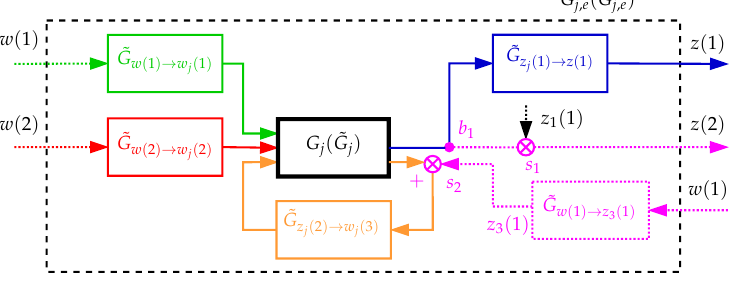
Figure 14. Obtaining the composite subsystems G j , e and ˜ G j , e , scaled by its environment, by connecting the reduced order input-output transfer functions (IOTF) to the inputs and outputs of the examined subsystem G j or reduced order subsystem ˜ G j , respectively.